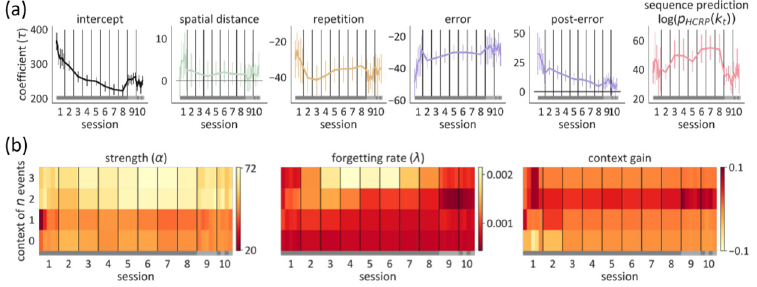
Fig 4. Fitted parameter values shown session by session, and at a subsession resolution in the initial and final sessions. The grey band on the bottom of each plot shows the sequence that participants practiced: the old sequence in sessions 1–8 (dark grey), the new sequence in session 9 (light grey), and both sequences alternately in session 10. Point distance in (a) and cell width in (b) are proportional to data bin size—we fitted the model to 5 epochs within sessions 1, 9, and 10 to assess potentially fast shifts. (a) Fitted values of the response parameters in units of τ [ms]. The error bars indicate the 95% CI for the between-subjects mean. (b) Fitted values of the strength α (left) and forgetting rate λ (middle) parameters are shown, as well as their joint effect on prediction (right). A context of n previous events corresponds to level n in the HCRP. Lower values of α and λ imply a greater contribution from the context to the prediction of behavior. The context gain for context length n is the decrease in the KL divergence between the predictive distribution of the complete model and a partial model upon considering n previous elements, compared to considering only n − 1 previous elements. Note that the scale of the context gain is reversed and higher values signify more